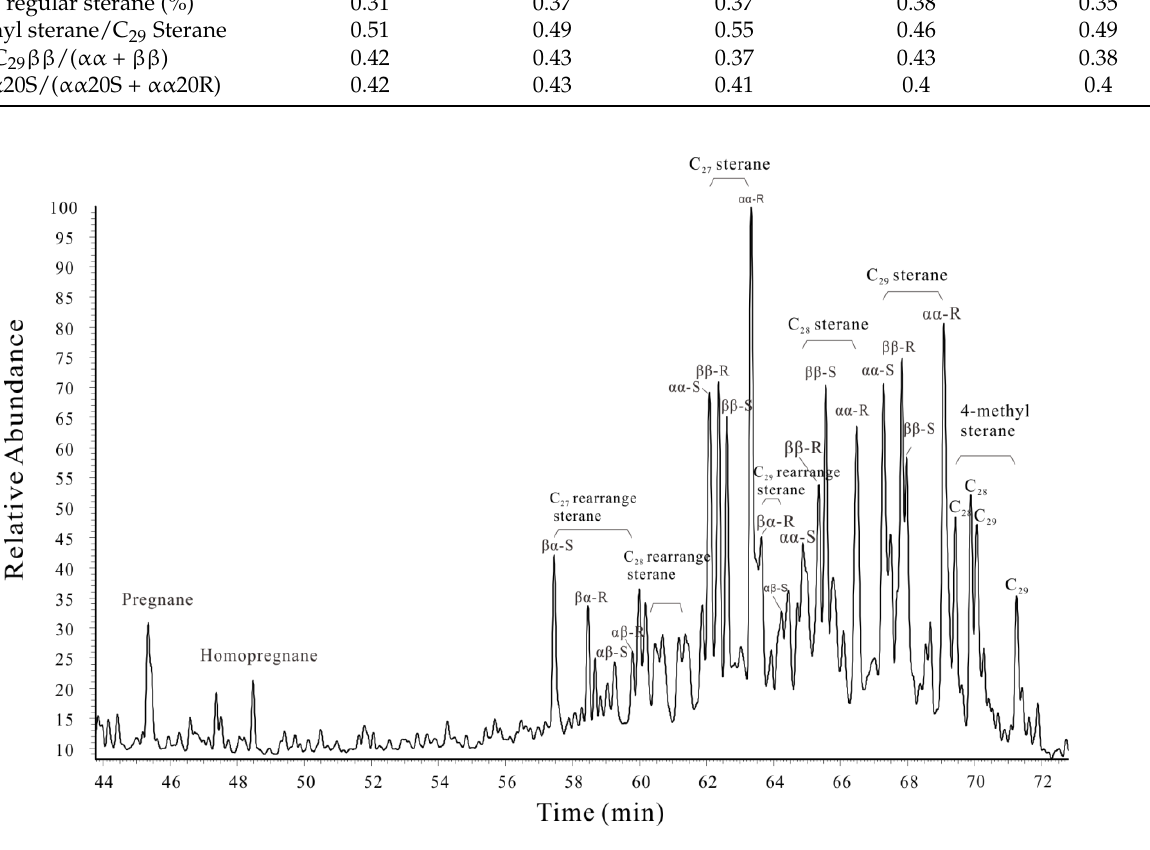
Figure 7. The distribution of sterane compounds in saturated hydrocarbons of organic material from representative reservoir bitumen in the Maidiping Member (sample number: XQ18-5) (m/z 217 chromatogram-mass spectrum).